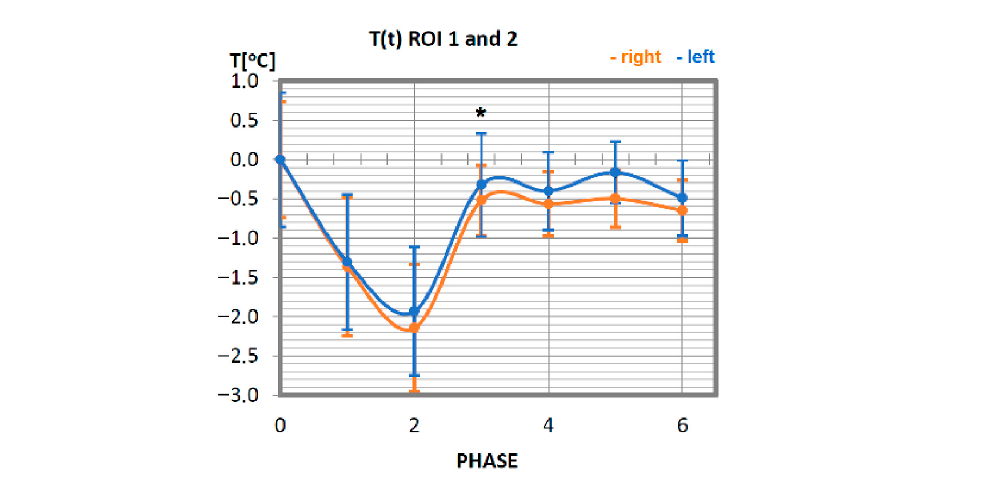
Figure 3. Temperature time (0 to 6 phase of training according to methods) changes of the wrist elbow flexor muscles obtained before and after training using a rowing ergometer for the studied group of athletes. The largest but not statistically significant differences were marked with *, p = 0.08.